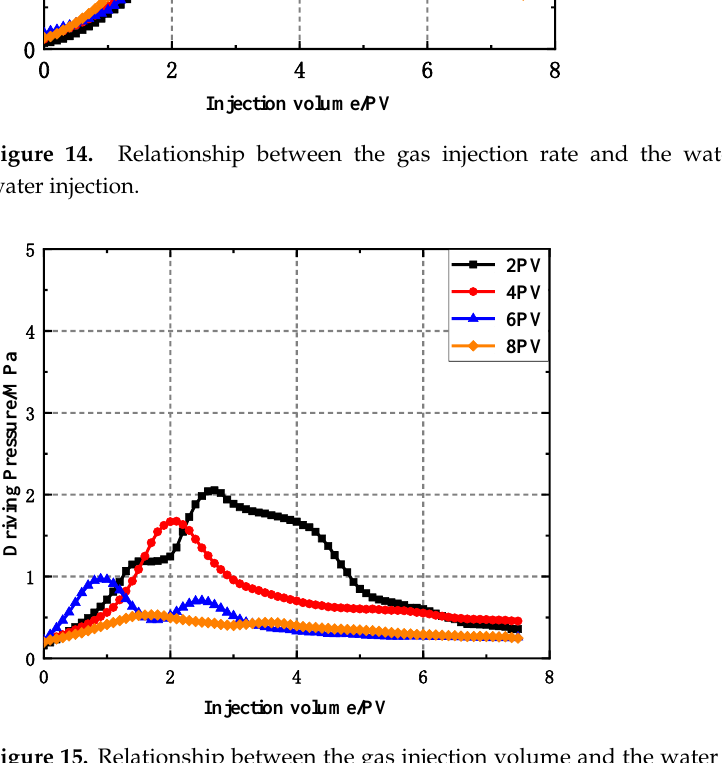
Figure 15. Relationship between the gas injection volume and the water injection volume during gas